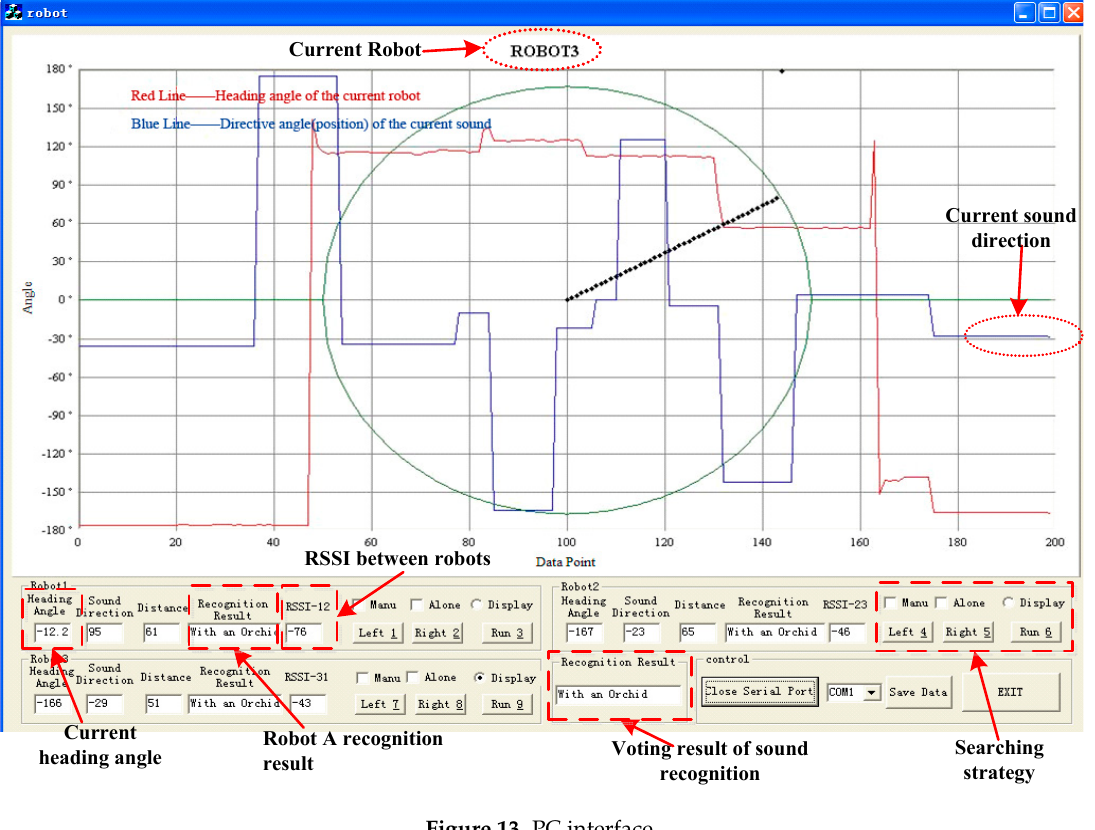
Figure 13. PC interface.